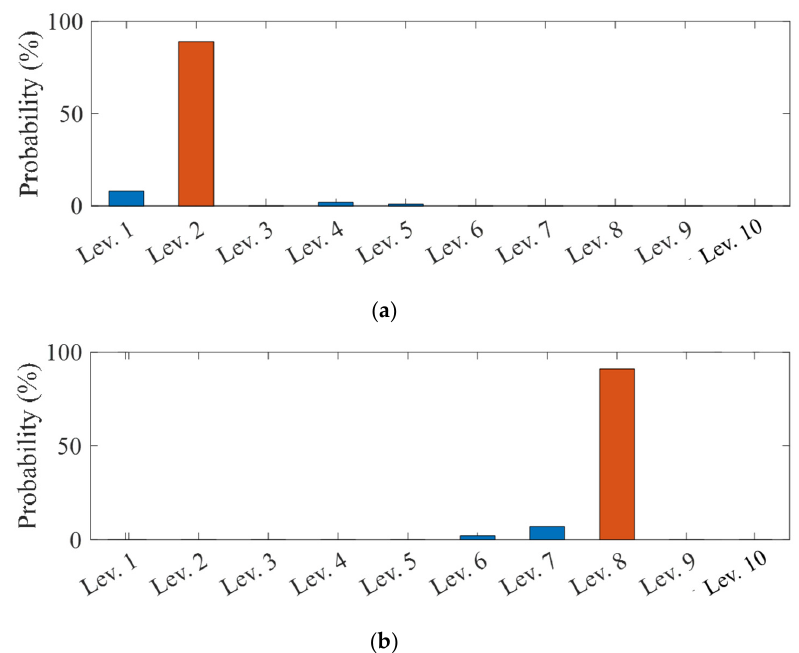
Figure 10. Generalization test results for the ( a ) Test-#1 and ( b ) Test-#2 specimens.